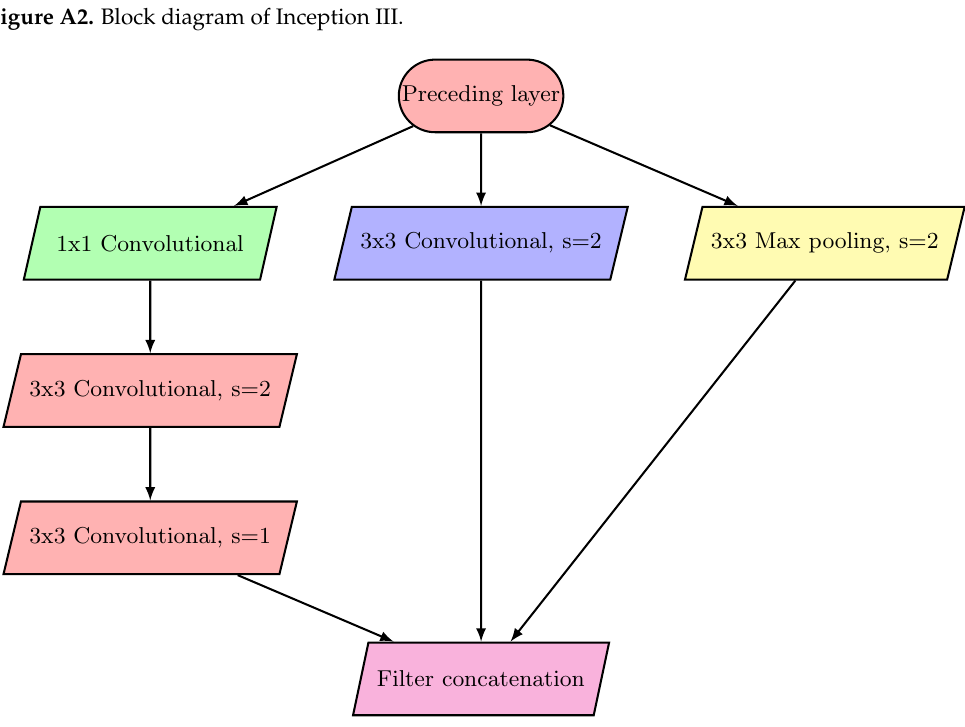
Figure A3. Block diagram of Reduction